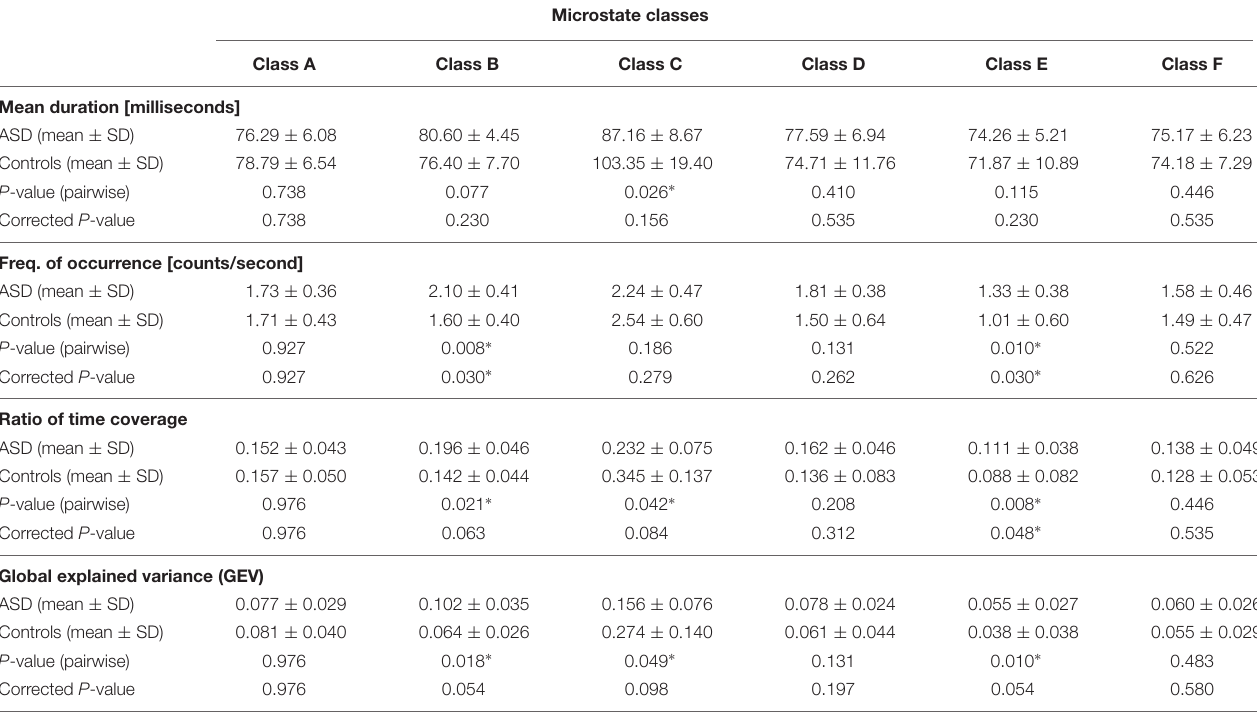
TABLE 1 | Temporal parameters in the microstate analysis of the ASD and control